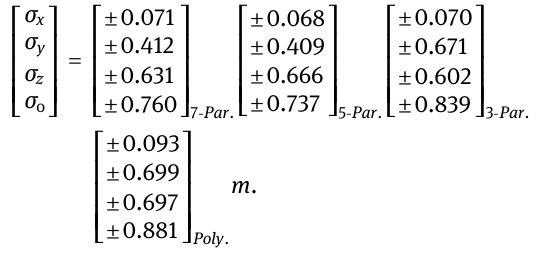
Table 2 indicates the obtained polynomial algorithm para -